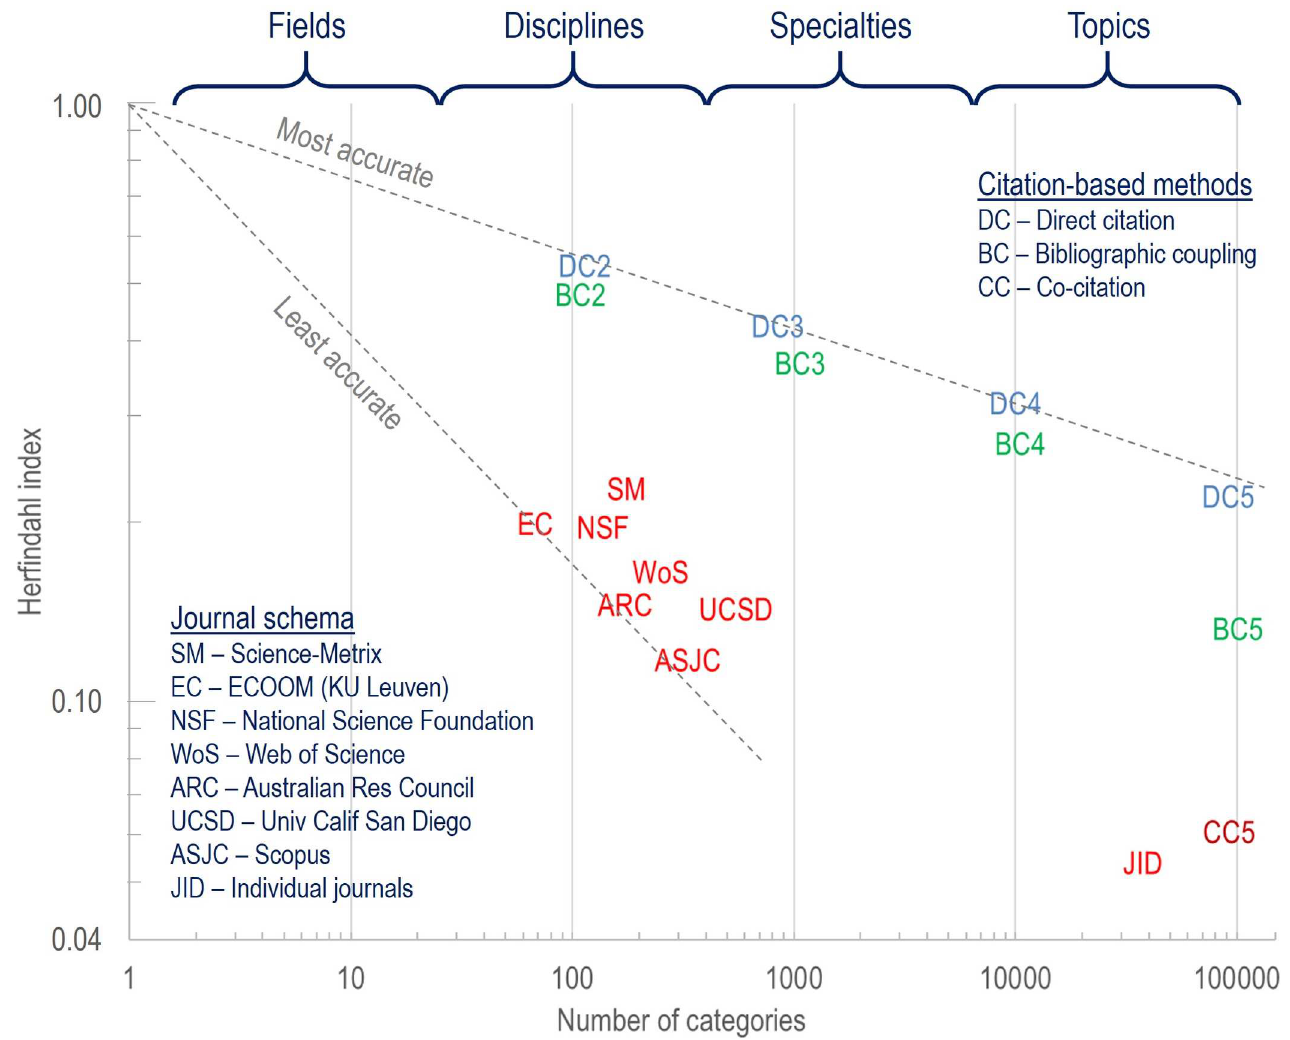
Fig 1. Relative accuraciesof 17 document clustering solutions, adapted from reference19. Designations of fields, disciplines,specialtiesand topics in terms of numbers of categoriesacross all of science are not meant to be exact, but rather conceptual.